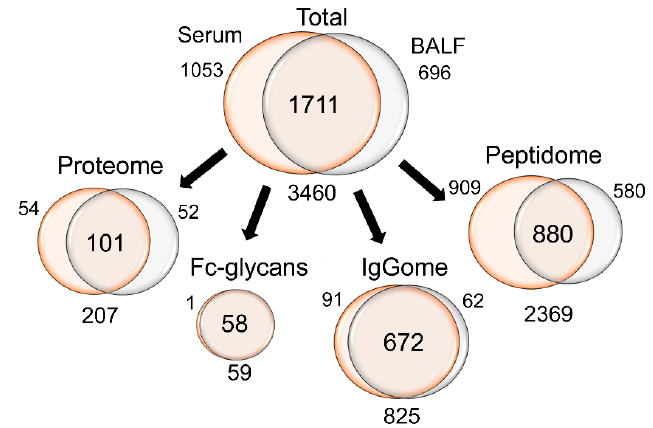
Figure 2. Data overview. Overview of the number of features that were acquired from the two sample types. Note that the identified features needed to be found in at least 50% of all serum or all BALF samples. In terms of overlap between BALF and serum, the IgGome and Fc-glycans are superior with approximately >80% of all features detected in both sample types (compared to <50% for other features).